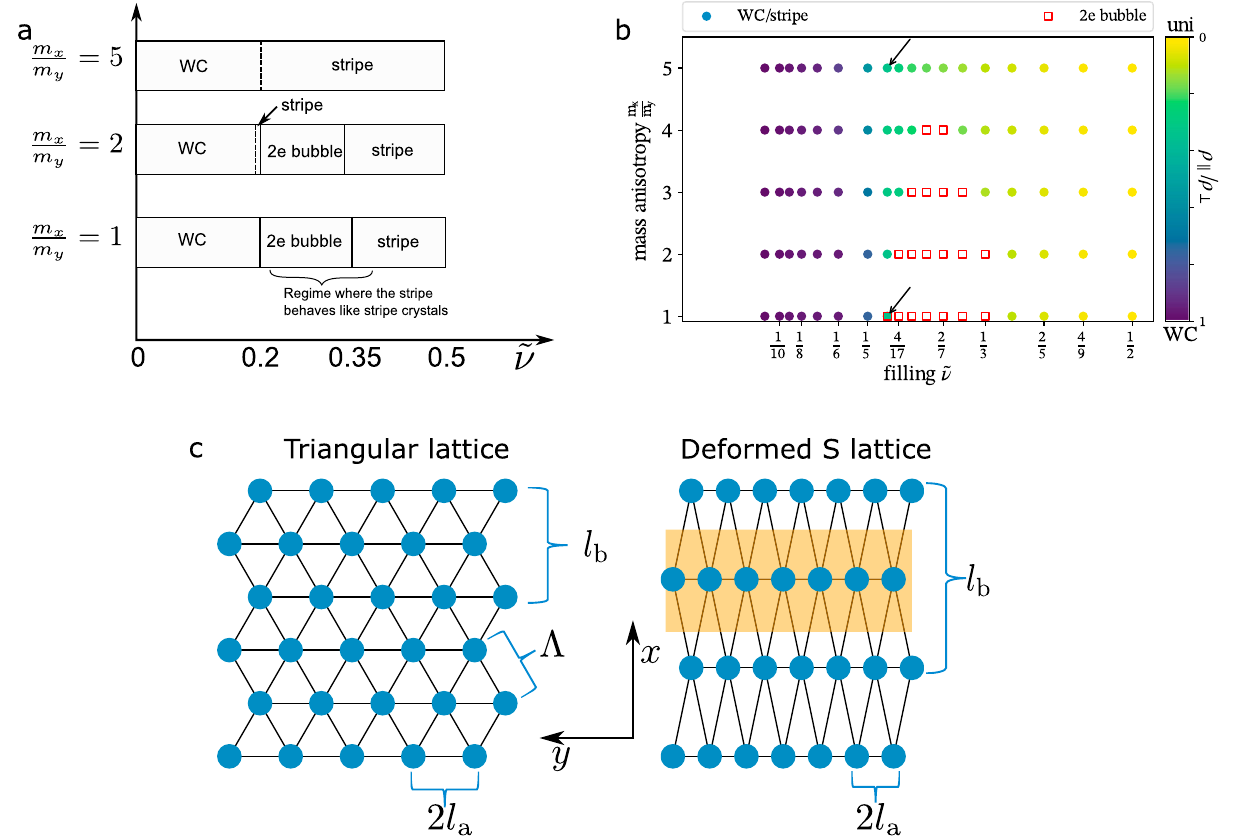
Fig. 1 Phase diagrams and an illustration of the lattice. Phase diagram: ( a ) Hartree – Fock results as a function of the mass ratio m x / m y and the partial fi lling ~ ν . The stripe phase is assumed to be unidirectional. The regime of stripe crystal [covered by the 2-electron (2e) bubble for m x = m y ] is taken from the isotropic calculation in refs. 45,47,49 . For m x / m y = 2, a small stripe regime sandwiched between the Wigner crystal (WC) and 2e bubble appears around ~ ν ¼ 0 : 2 and it eventually takes over the 2e bubble phase at m x / m y = 5. b DMRG results. Both the stripe crystal and the WC take 2D lattice order. The colour represents the modulation anisotropy (cid:2) ρ k = (cid:2) ρ ? , where (cid:2) ρ k is the maximal density wave amplitude (cid:2) ρ ð q Þ with a non-zero wave vector q in the stripe direction and (cid:2) ρ ? is the counterpart in the direction perpendicular to the stripe (see Methods). Lighter colour indicates higher anisotropy, and the highest anisotropy is reached by the unidirectional stripe. c The lattices of the Wigner crystal and the stripe crystal. Left: triangular Wigner crystal in isotropic systems. Right: stretched (S) lattice deformation. When the lattice deformation is suf fi cient, this becomes a stripe crystal and the stripe phase forms after the modulation along y -direction becomes small, indicated by the orange